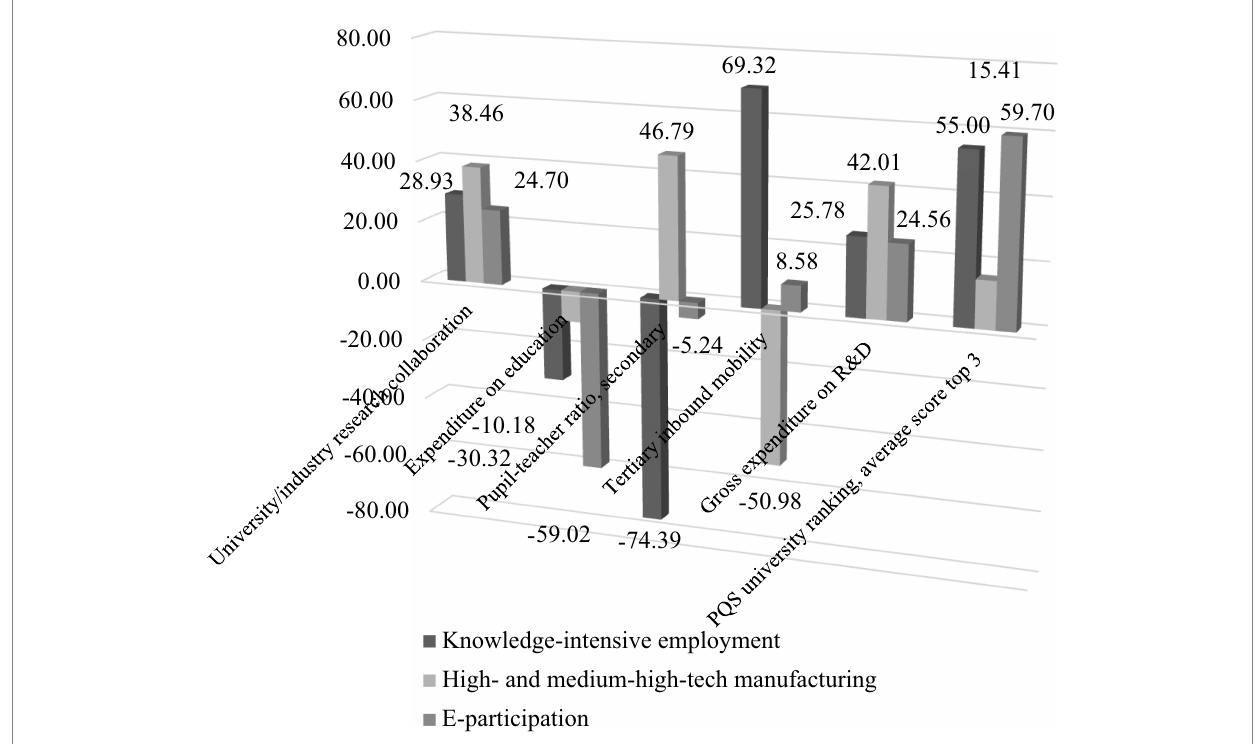
FIGURE 2 Correlation between the directions of higher education’s development and the results for the social and investment model of economic growth in emerging economies in 2020, %. Calculated and built by the